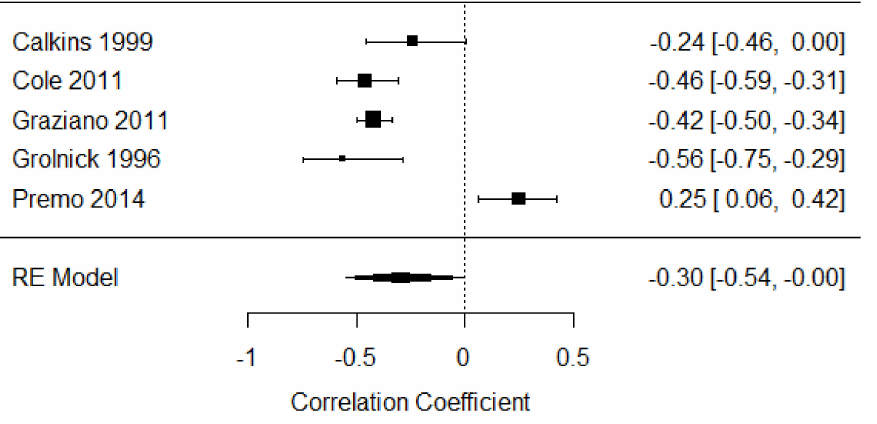
Figure 5. Forest plot of year 3 disengagement of attention. Note: RE = Random-Effects Model.